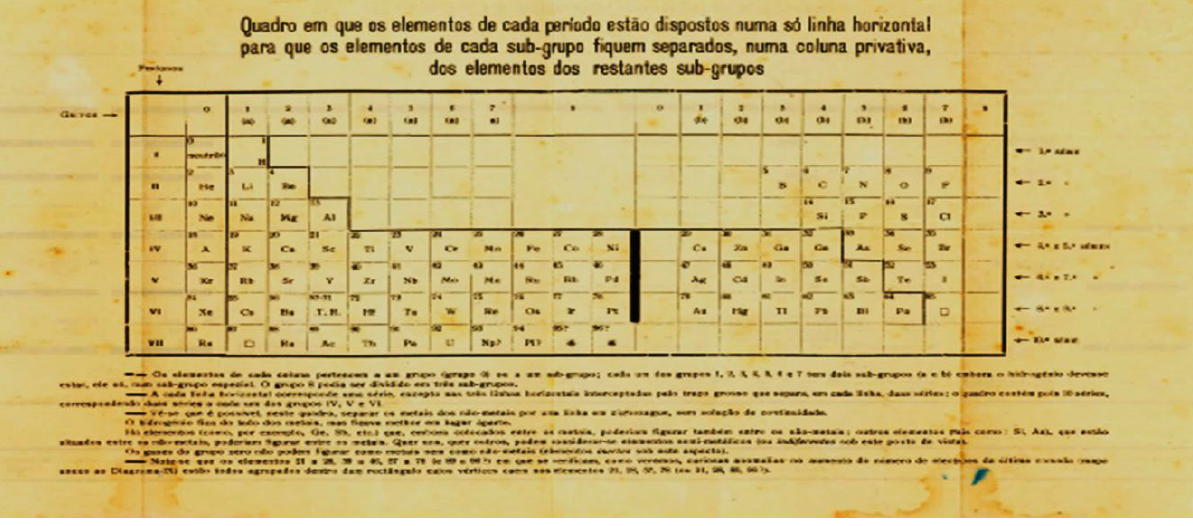
Figure 6b. Verso of the unfolding chart with periodic classification system included in F. Sena Esteves’ textbook (ref.